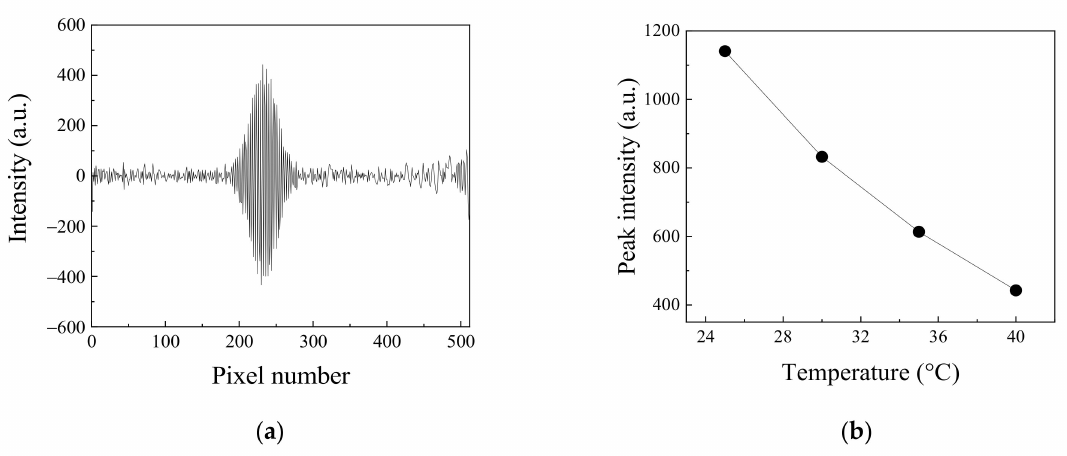
Figure 4. ( a ) The interferogram measured in the static modulated spectrometer with the modified Sagnac interferometer when applied current and temperature were 0.55 A and 40 ◦ C, respectively: ( b ) Peak intensity change in the interferogram according to the change of the temperature of the light emitting diode. Applied current to light emitting diode was fixed to 0.55